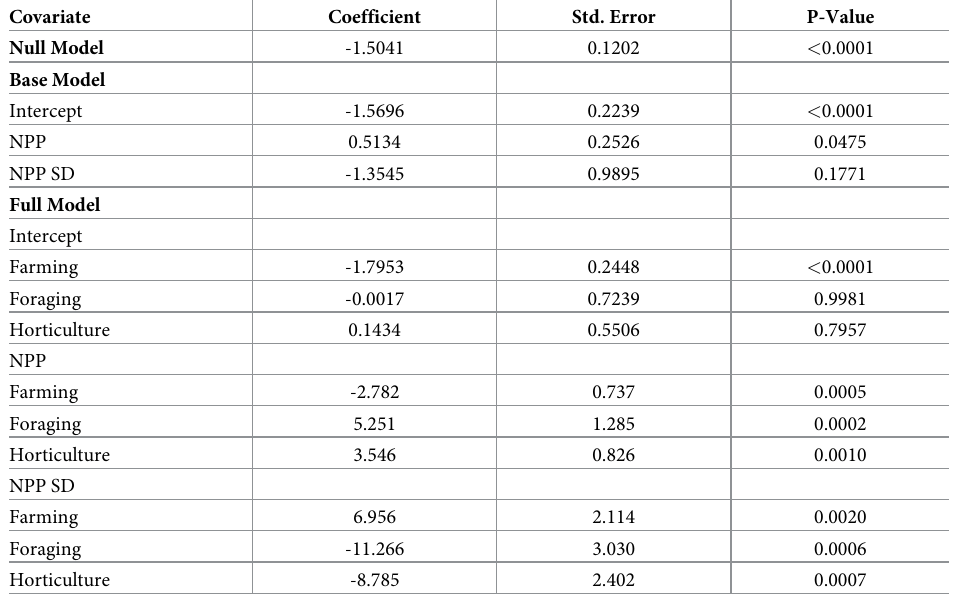
Table 1. Results of binomial GLMs evaluating proportional violence (PV) as a function of mean and SD NPP. Coefficient estimates and standard errors are shown as log of the odds ratio. Coefficients in the full model are relative to the farming reference class.